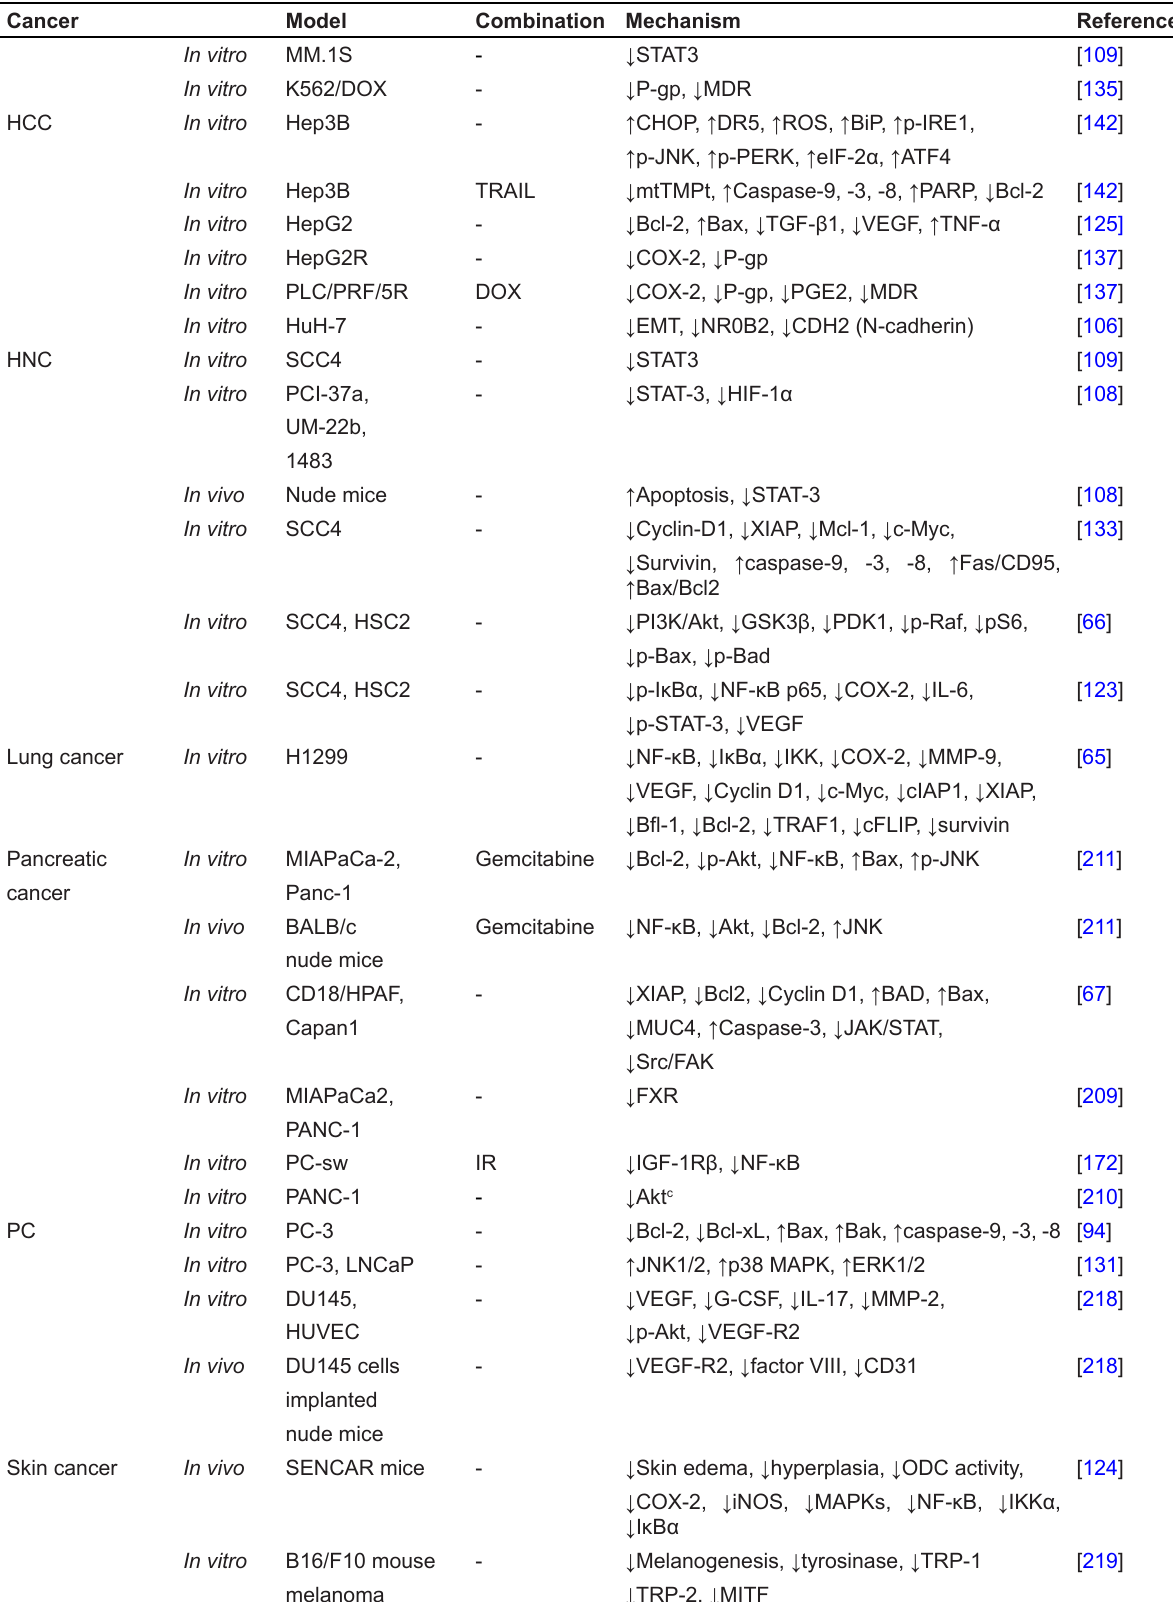
Table 1. Potential of GS and its derivatives in the prevention and treatment of cancer ( continued ) Cancer Model